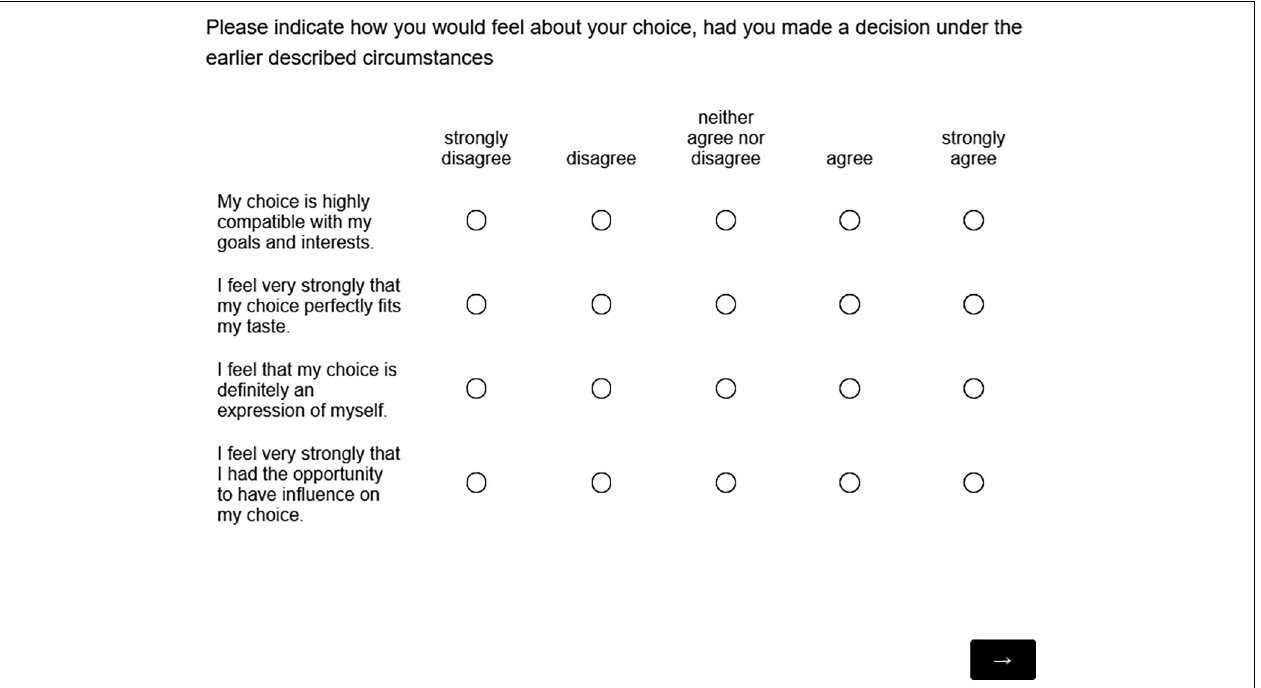
FIGURE B1 | Expected autonomy